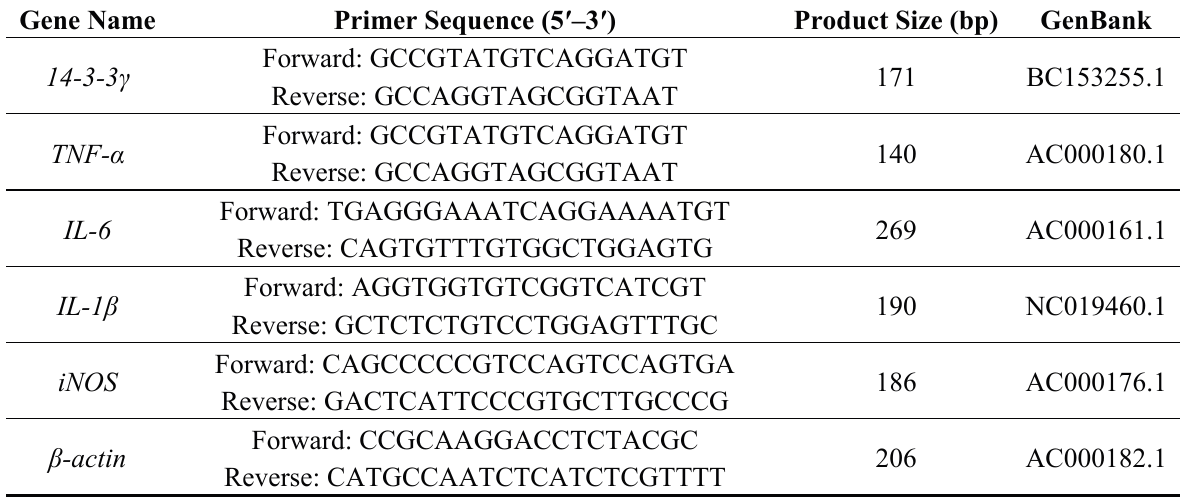
Table 2. Sequence of primers used in current investigation in